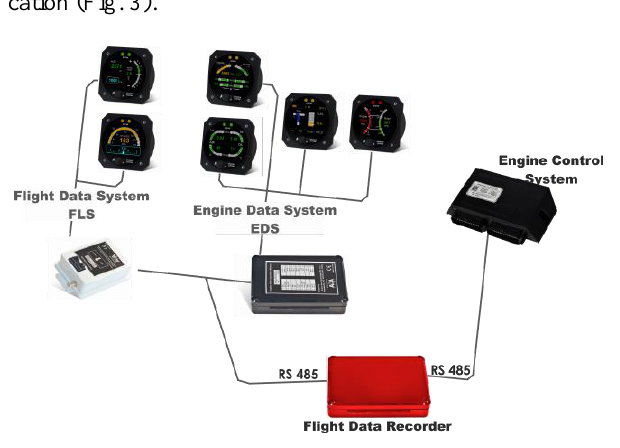
Fig. 3. Flight Data Recorder used in the research